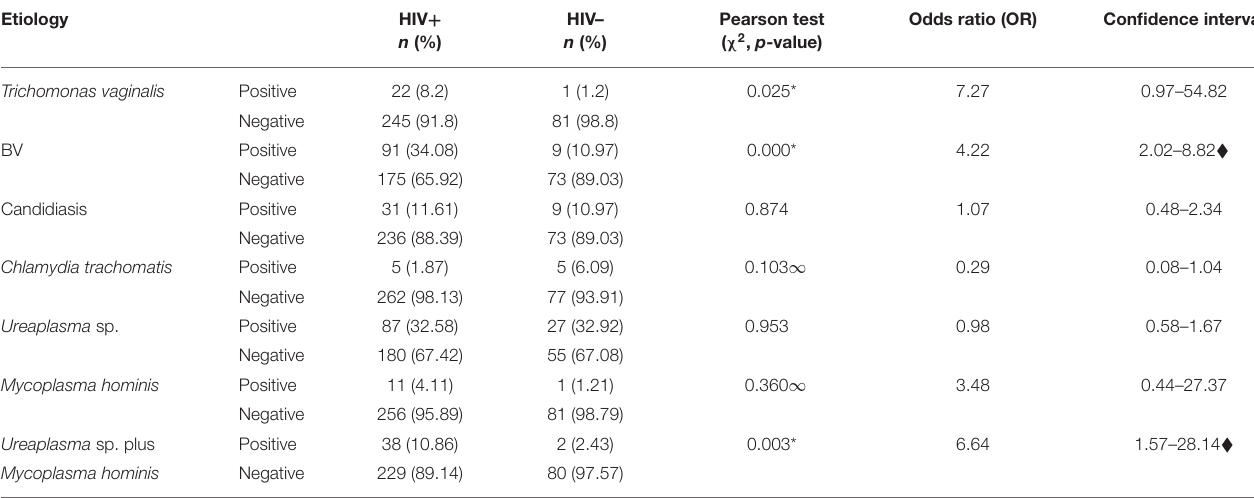
HIV– Pearson test Odds ratio (OR) Confidence interval n (%) n (%) ( χ 2 , p -value)